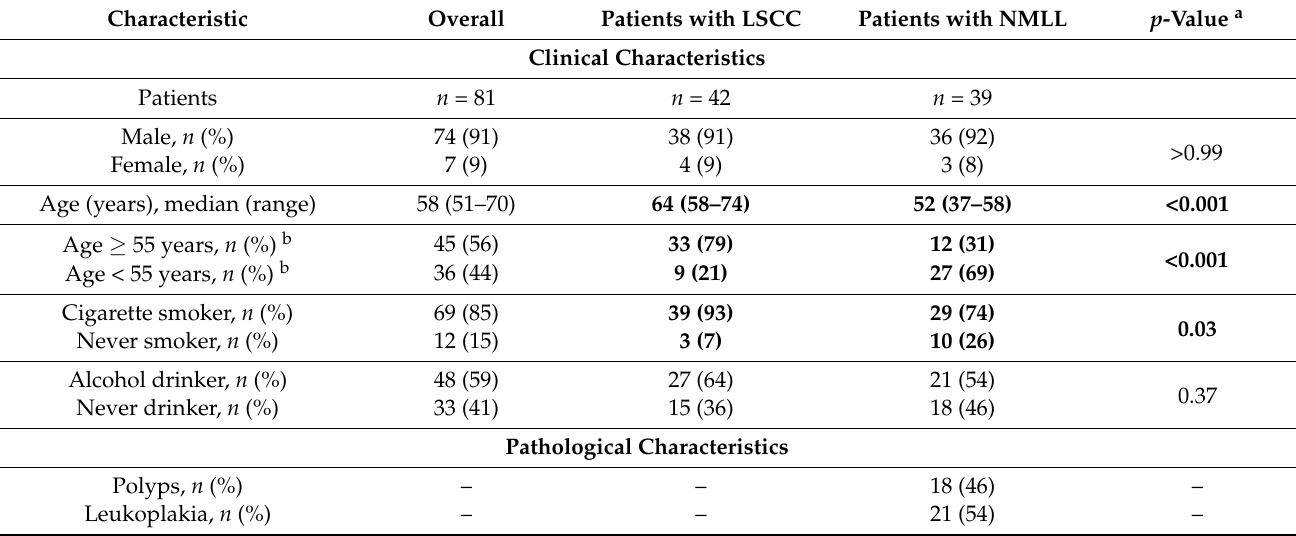
Table 1. Clinicopathological characteristics and